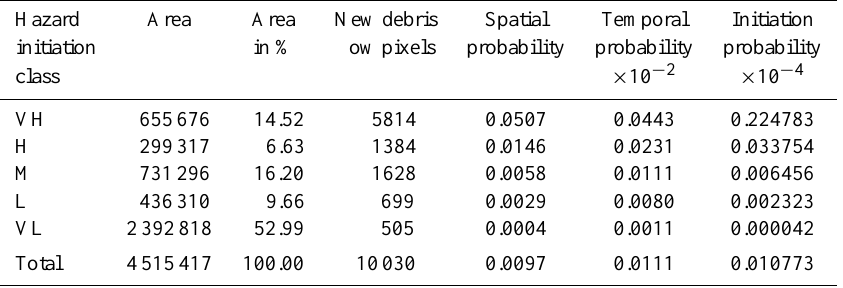
Table 1. Calculated probability values of the debris flow hazard initiation map. VH: very high, H: high, M: medium, L: low, VL: very low. Hazard Area Area New debris Spatial Temporal Initiation initiation in % flow pixels probability probability probability